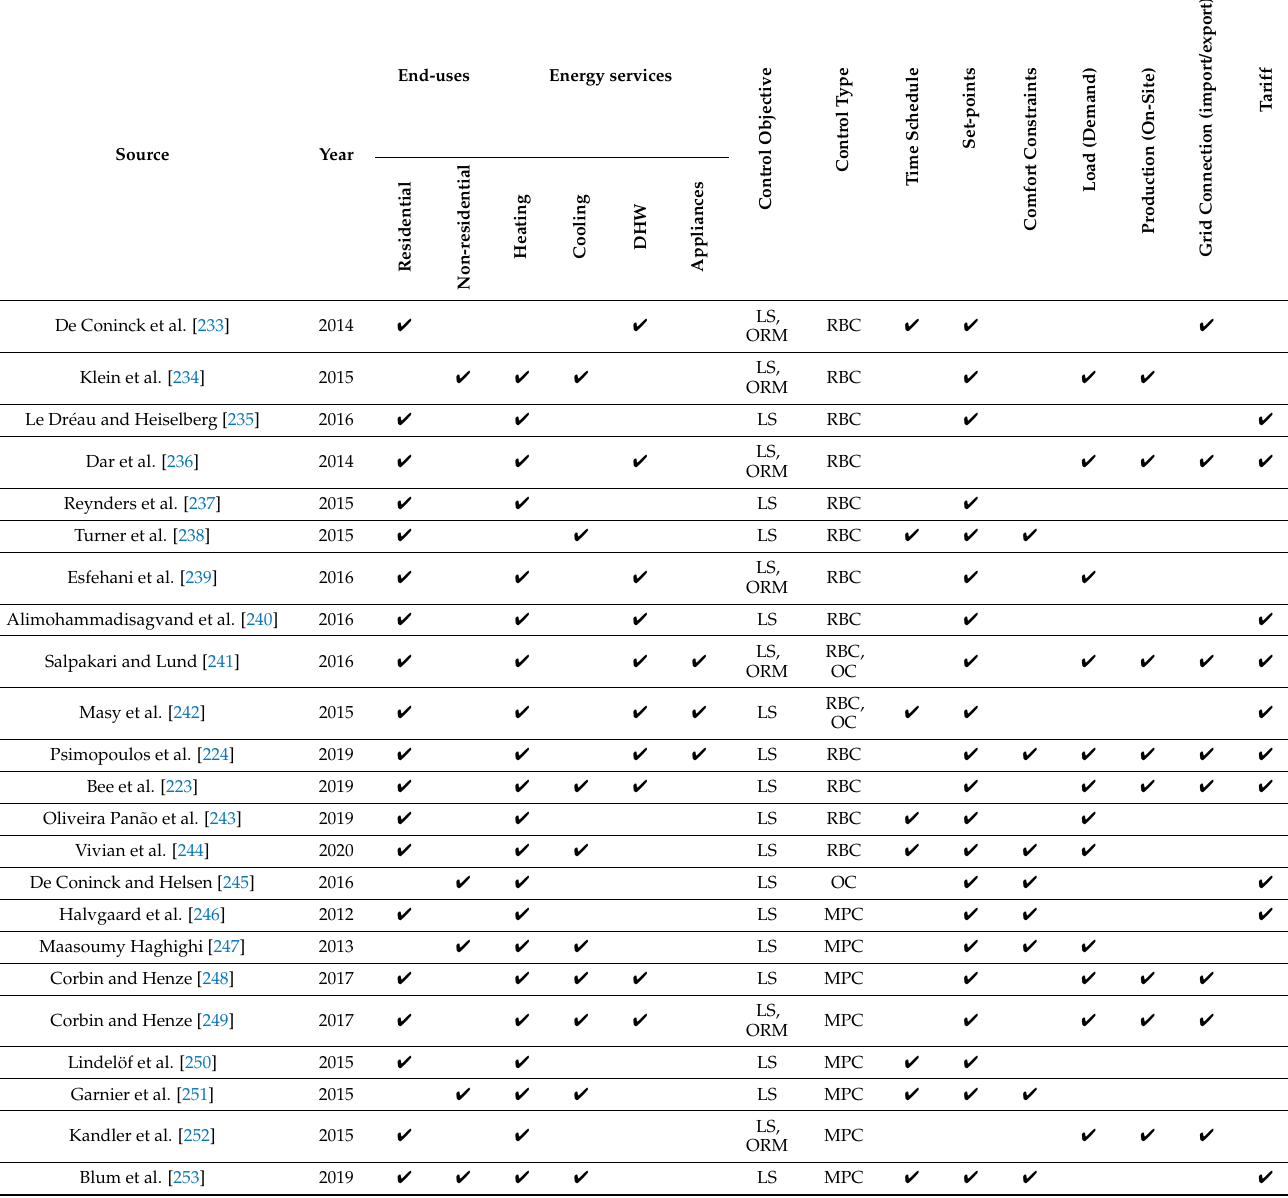
Table 6. Control strategies aimed at building flexibility for different end-uses and